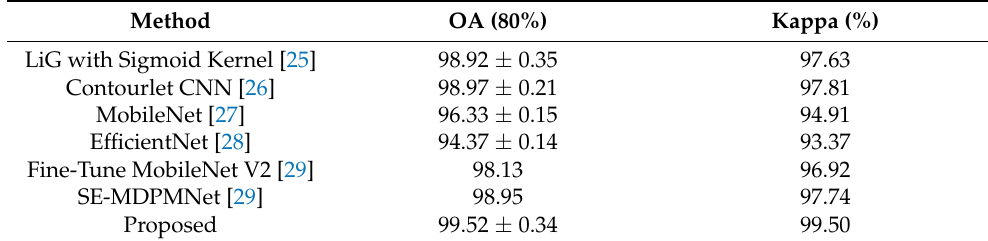
Table 5. Kappa (%) of six methods and the LCNN-CMGF method at the training ratio of 80% in the UCM21 dataset.